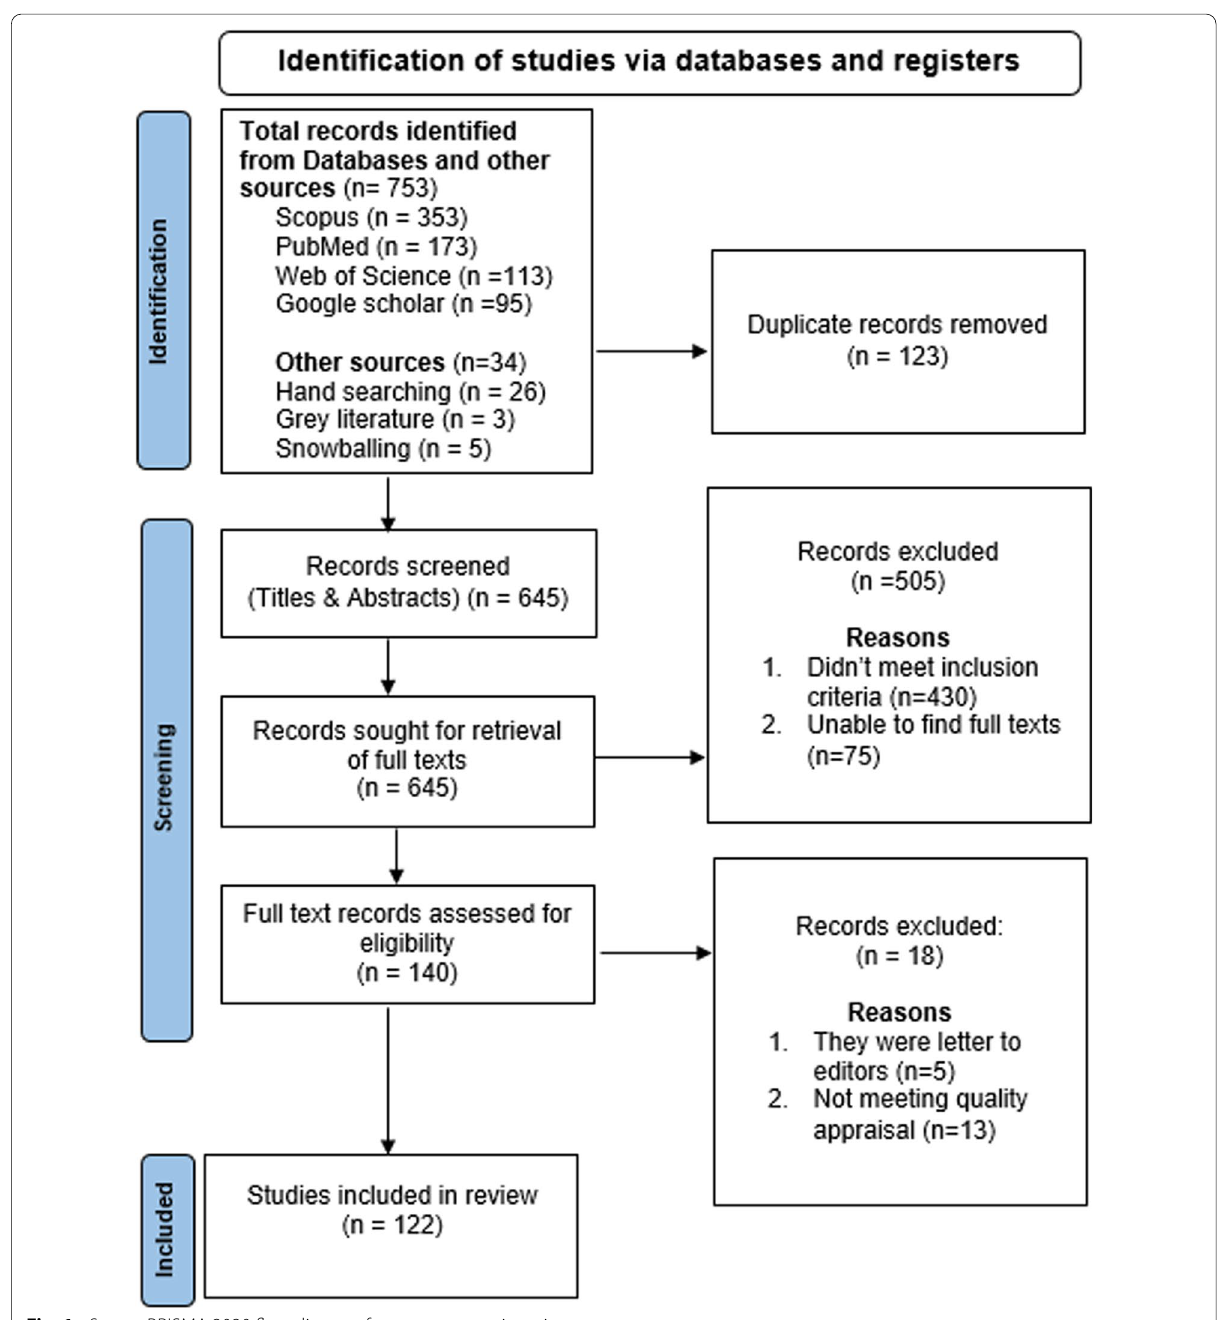
Fig. 1 Source : PRISMA 2020 flow diagram for new systematic